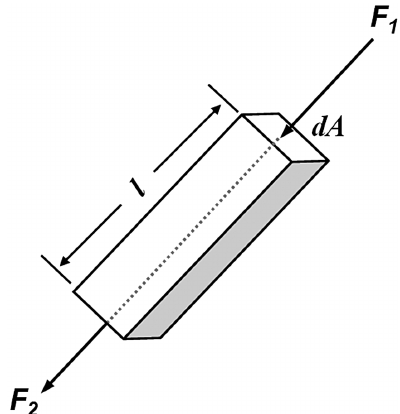
Figure 1. A general scheme and the related variables for intercep- tion of a light beam by a small column of canopy.